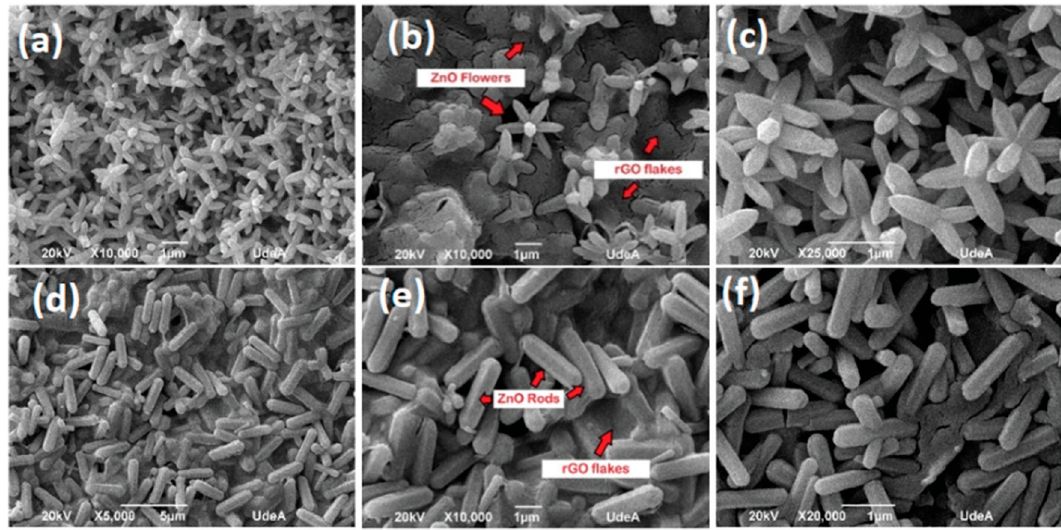
Figure 17. SEM micrographs of ( a – c ) rGO/ZnO flowers and ( d – f ) rGO/ZnO rods. Reproduced from [115] with permission from The Royal Society of Chemistry.